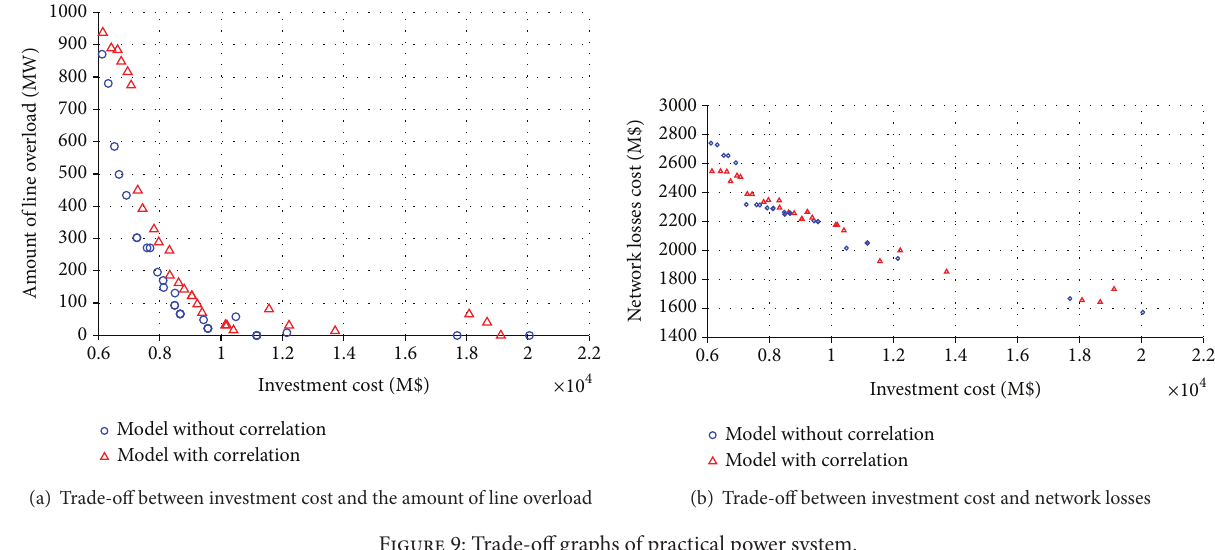
Figure 9: Trade-off graphs of practical power system.